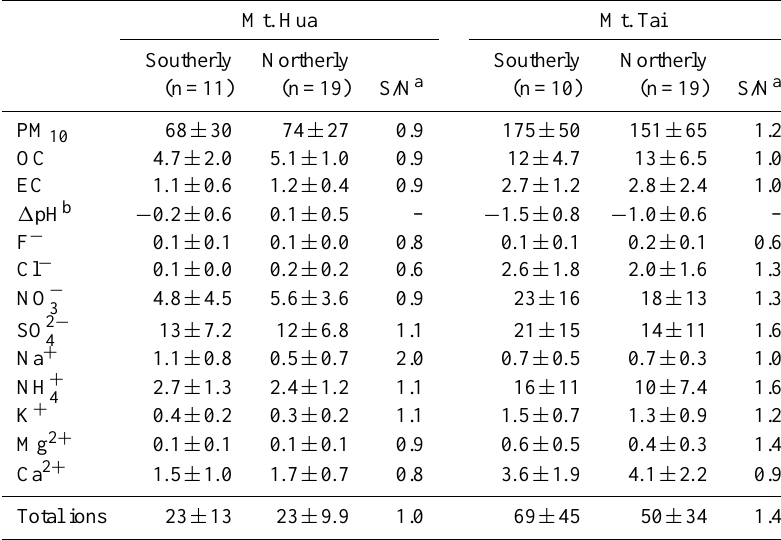
Table 3. Concentrations of species in PM 10 transported southerly and northerly at Mt. Hua and Mt. Tai during the non-dust storm period, µgm − 3 . Mt. Hua Mt. Tai